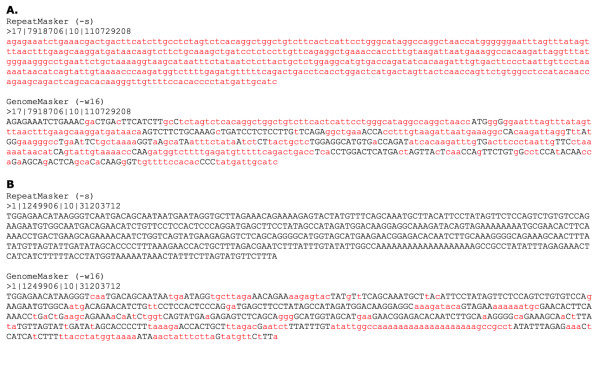
Examples of masking style of different masking programs. Masked nucleotides are shown by red lowercase letters. There are some DNA regions that are extensively masked by RepeatMasker (A) and some regions where RepeatMasker does not find any repetitive motifs (B). Both programs are executed at similar sensitivity level.